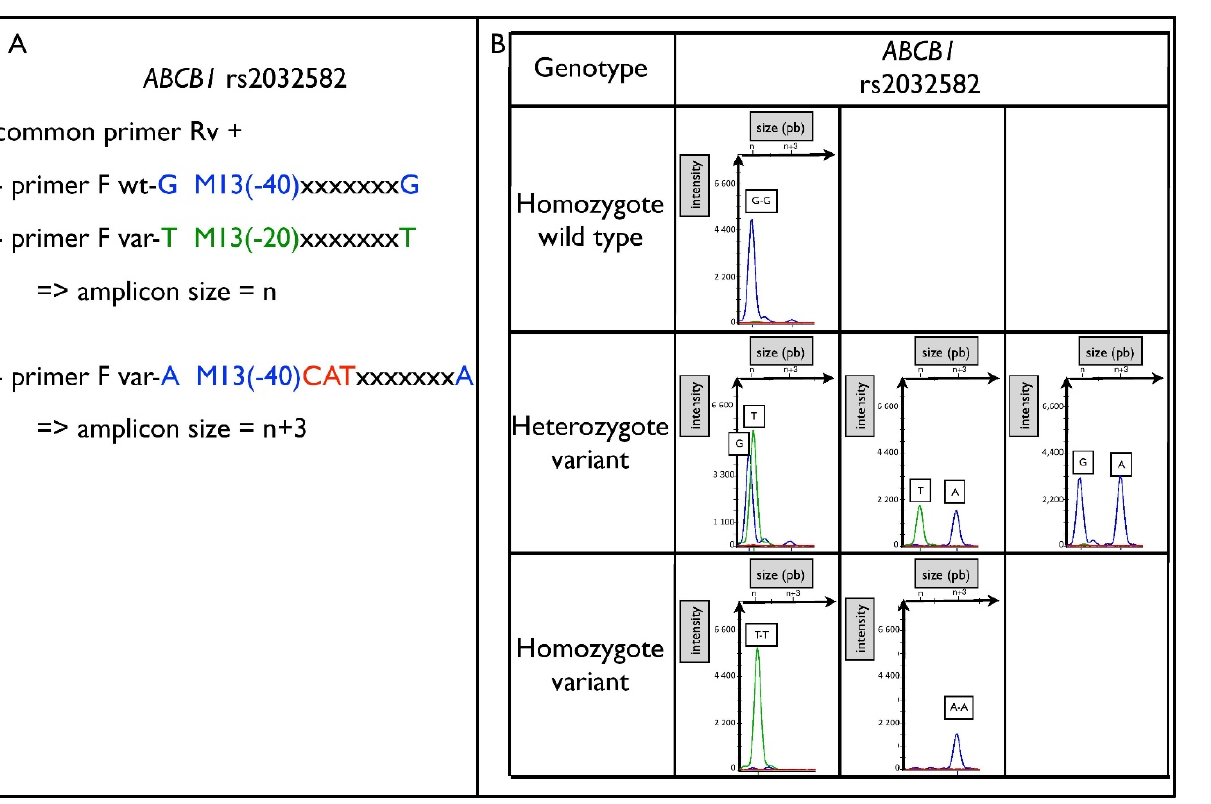
Table 2. Influence of the amount of DNA analyzed on the performance of the analysis, expressed as peak intensity.